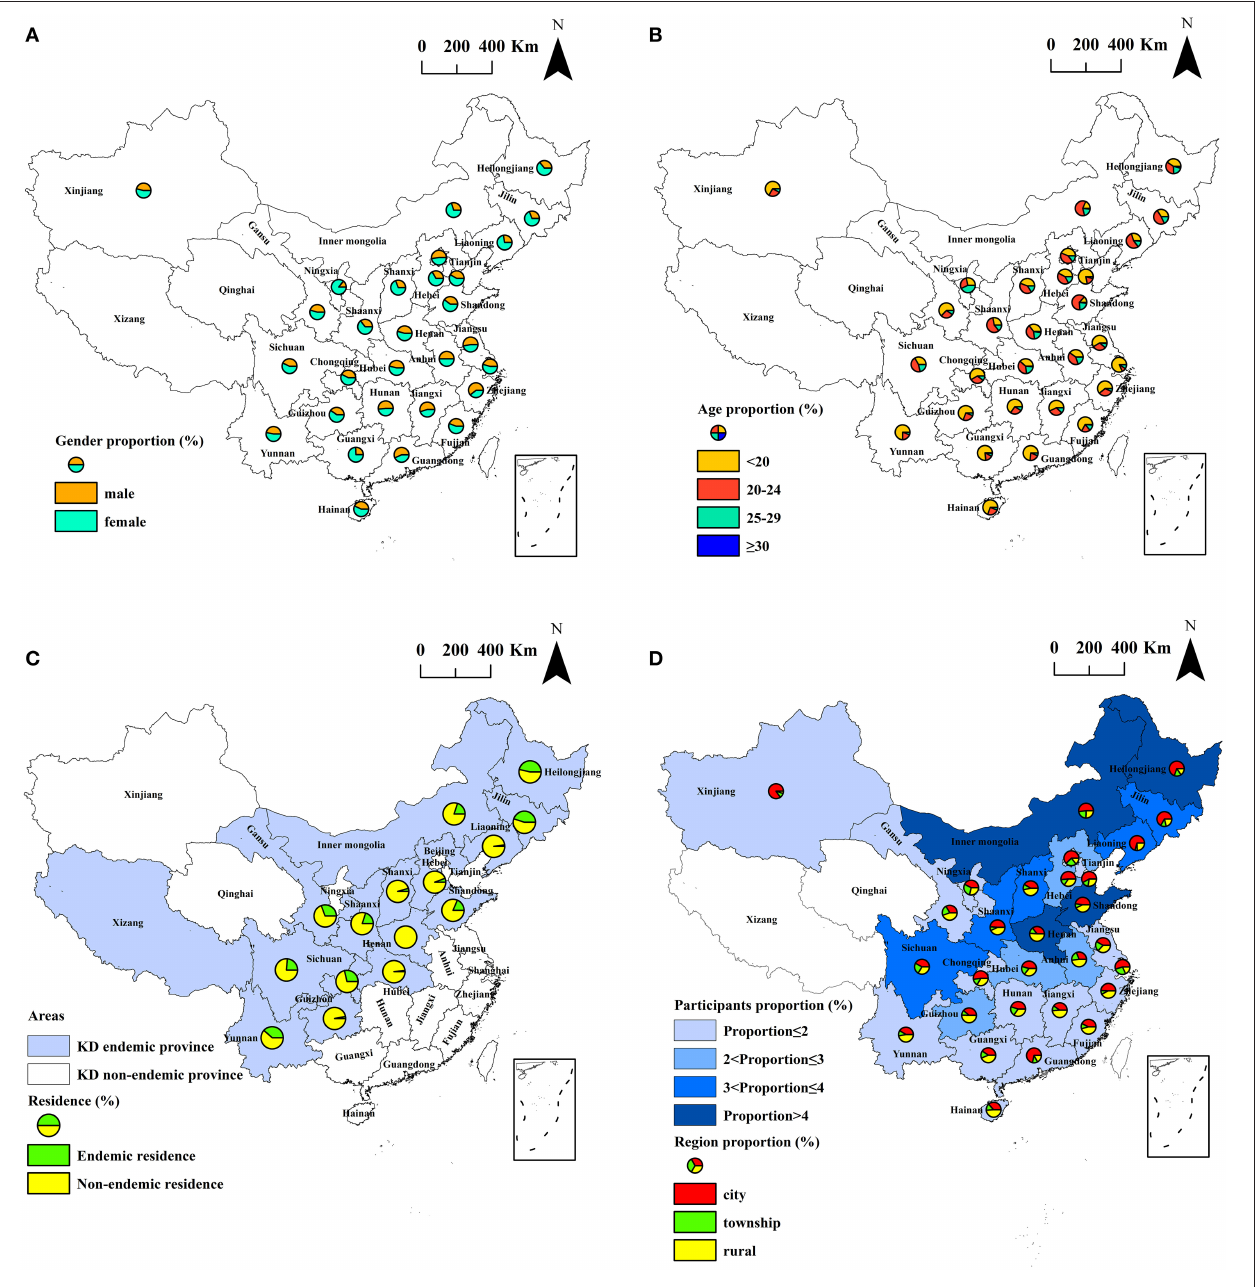
FIGURE 1 | Spatial distribution of the subjects investigated. (A) spatial distribution of the gender of the subjects; (B) spatial distribution of the age of the subjects; (C) spatial distribution of subjects living in KD endemic areas and non-endemic areas; (D) spatial distribution of participants proportion and region proportion in different